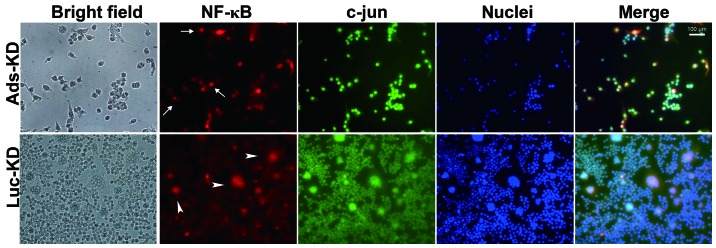
Adseverin (Ads) knockdown is associated with impaired RANK signaling. Signaling downstream of RANK was evaluated by nuclear factor-κB (NF-κB) and c-jun immunostaining on day 4 of osteoclastogenesis (OCG). NF-κB was activated in Luc-knockdown osteoclasts as shown by its exclusively nuclear distribution (arrows). The majority Ads-knockdown macrophages did not exhibit active NF-κB, as shown by its cytoplasmic distribution. Luc knockdown and Ads knockdown demonstrated activated nuclear c-jun, a transcription factor involved in RANK survival signaling in osteoclasts. RANK, receptor activator of nuclear factor-κB.